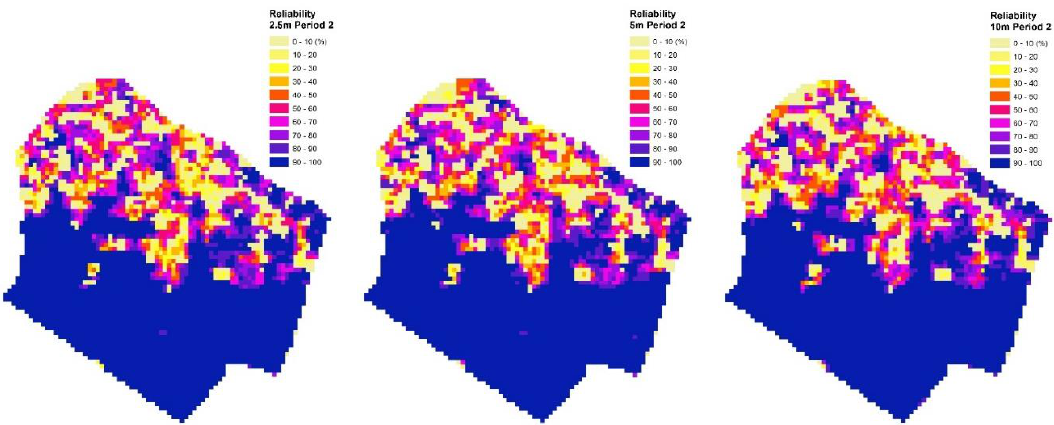
Figure 7. Spatial display of the percentage of cells prescribed with the same treatment as in the Reference inventory for Period 2 for the optimizations containing positioning errors (standard deviations of 2.5, 5 and 10 m from left to right, respectively).